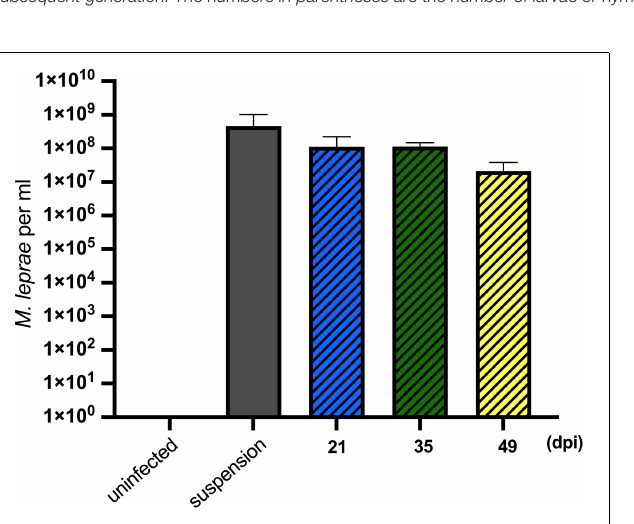
FIGURE 1 | Mycobacterium leprae Thai-53 strain enumeration in tick-derived cell lines. ISE6 cells were infected with 1 × 10 8 M. leprae /flask. Mycobacterium leprae in cells were harvested at 21, 35, and 49 dpi. Mycobacterium leprae DNA quantification was accessed by the RLEP qPCR. Two biological replicates were performed. Statistically significant differences ( p < 0.05) were analyzed by Mann-Whitney test when comparing with initial